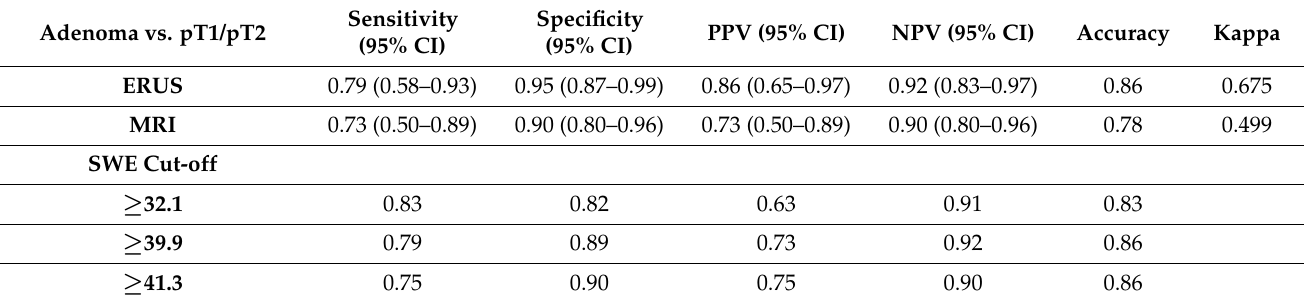
Table 2. Performance of endorectal ultrasound, magnetic resonance imaging, and shear-wave elas- tography for discrimination between adenoma and early rectal cancer.